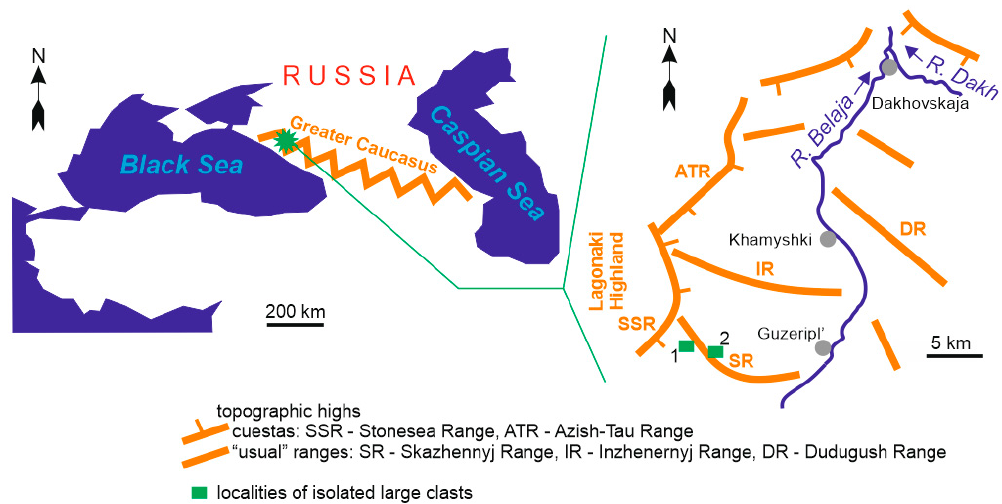
Figure 1. Location of the study area, its topographical elements, and the main large clast localities.